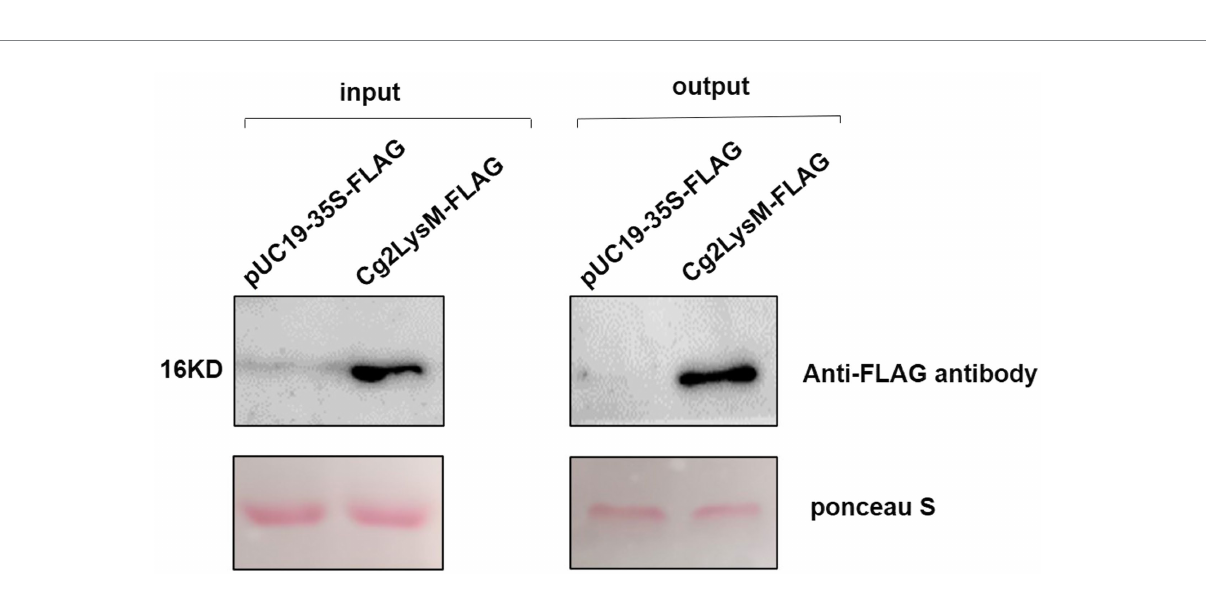
FIGURE 5 Analysis of chitin binding activity of Cg2LysM. Total protein extraction solutions from rubber tree mesophyll protoplasts expressing empty vector (control) and Cg2LysM were incubated with chitin beads, respectively. Chitin beads were boiled in phosphate buffer and analyzed by Western blot with primary antibody anti-flag antibody (1:10,000) and secondary FITC-conjugated goat antimouse antibody